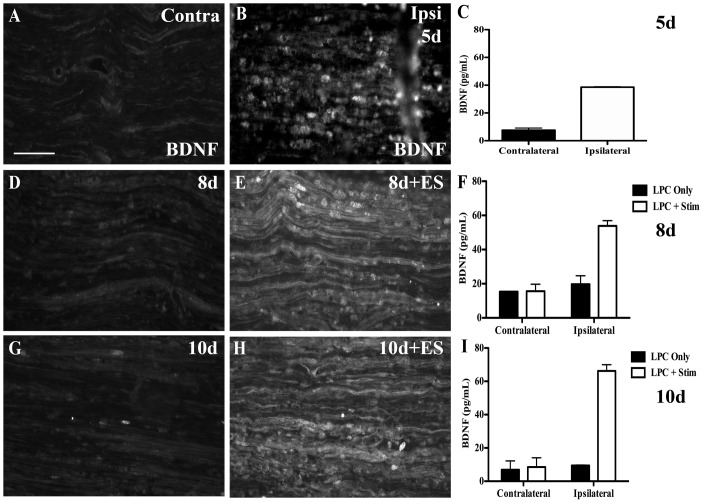
Increased BDNF protein in demyelination zone following 1 hr ES.Representative immunofluorescence (IF) photomicrographs from FG-positive focally demyelinated areas of tibial nerve sections immunostained for BDNF. Contralateral control nerves displayed only minimal BDNF IF (A). There was a marked increase in BDNF observed 5d post- lysophosphatidyl choline (LPC)/FG injection (B), largely within cells identified as ED-1 positive macrophages (data not shown). Temporal analysis of LPC focal demyelination +/- ES delivered 5 d post_LPC and as indicated in days post-LPC: 8d (D), 8d+ES (E), 10d (G), 10d+ES (H). Note: ES results in an increase in the BDNF IF signal detected 8 and 10 d post-LPC (3 and 5 days post-ES; E,H) relative to LPC only nerves (D,G). Summary bar graphs of BDNF protein levels measured by ELISA in samples of sciatic nerve bridging the site of demyelination are in agreement with BDNF IF (C, F, I). Asterisks indicate significant differences between experimental groups; **P<0.01. Scale bar = 100 µm.